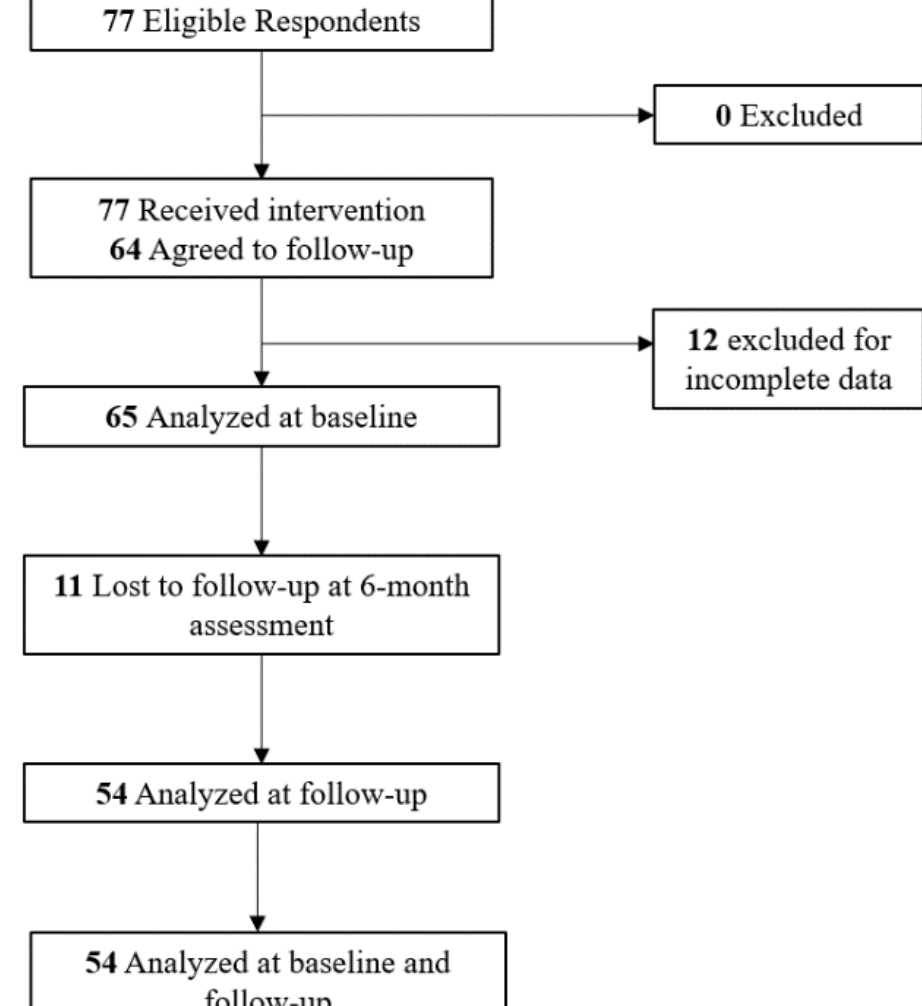
Figure 1. Consolidated Standards for Reporting of Trials (CONSORT) flow diagram.